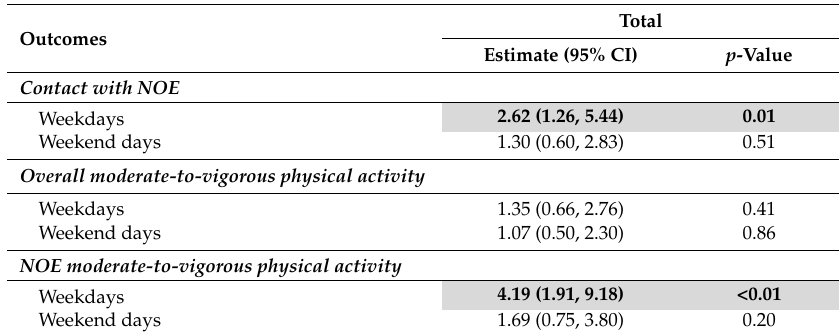
Table A6. Sensitivity models. Adjusted models for residential NOE availability defined as presence/ absence of green spaces at 300 m Euclidean buffer.